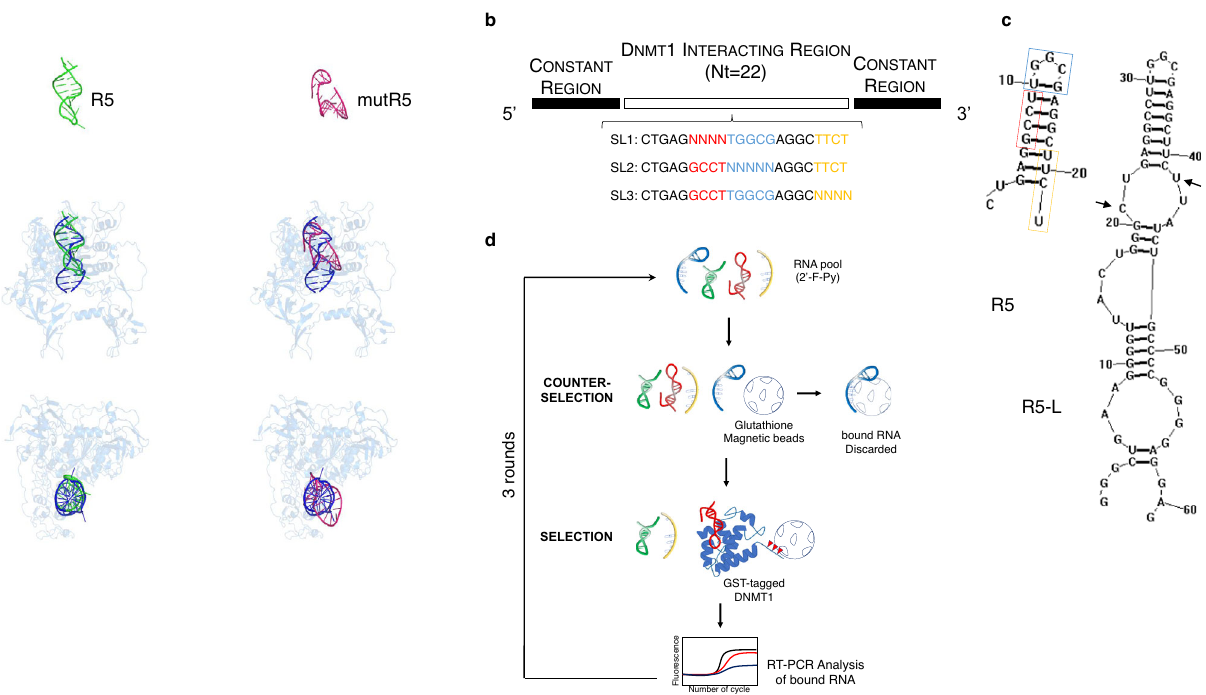
Fig.1|R5modelsandaptamerselectionprocess.a Cartoonrepresentationofthe tridimensional models of R5 (green) and mutR5 (magenta) and their complexes withtheDNMT1(blue)protein.TheDNAsubstrateoftheX-raystructureusedguide to build DNMT1 complexes is also shown in blue. b Diagram of the site-speci fi c randomized sub-libraries (SL1, SL2 and SL3) used as starting pool for the SELEX cycles. c Stem-looppredictedstructuresofR5andlongR5(R5-L).Theblackarrows indicate R5 sequence within R5-L. Regions within R5 that were randomized for the